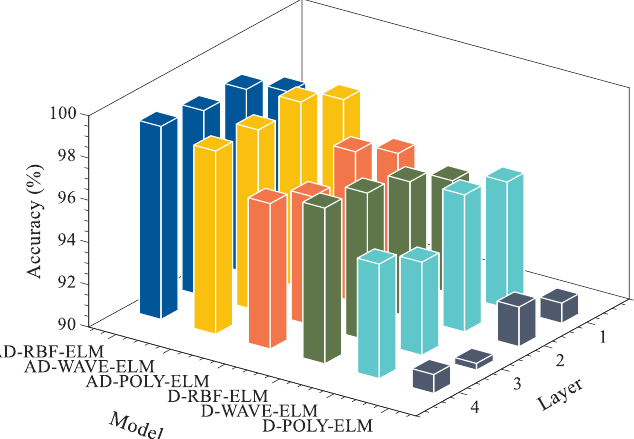
Figure 8. The accuracy rates of different DK-ELM models (Western Reserve University).